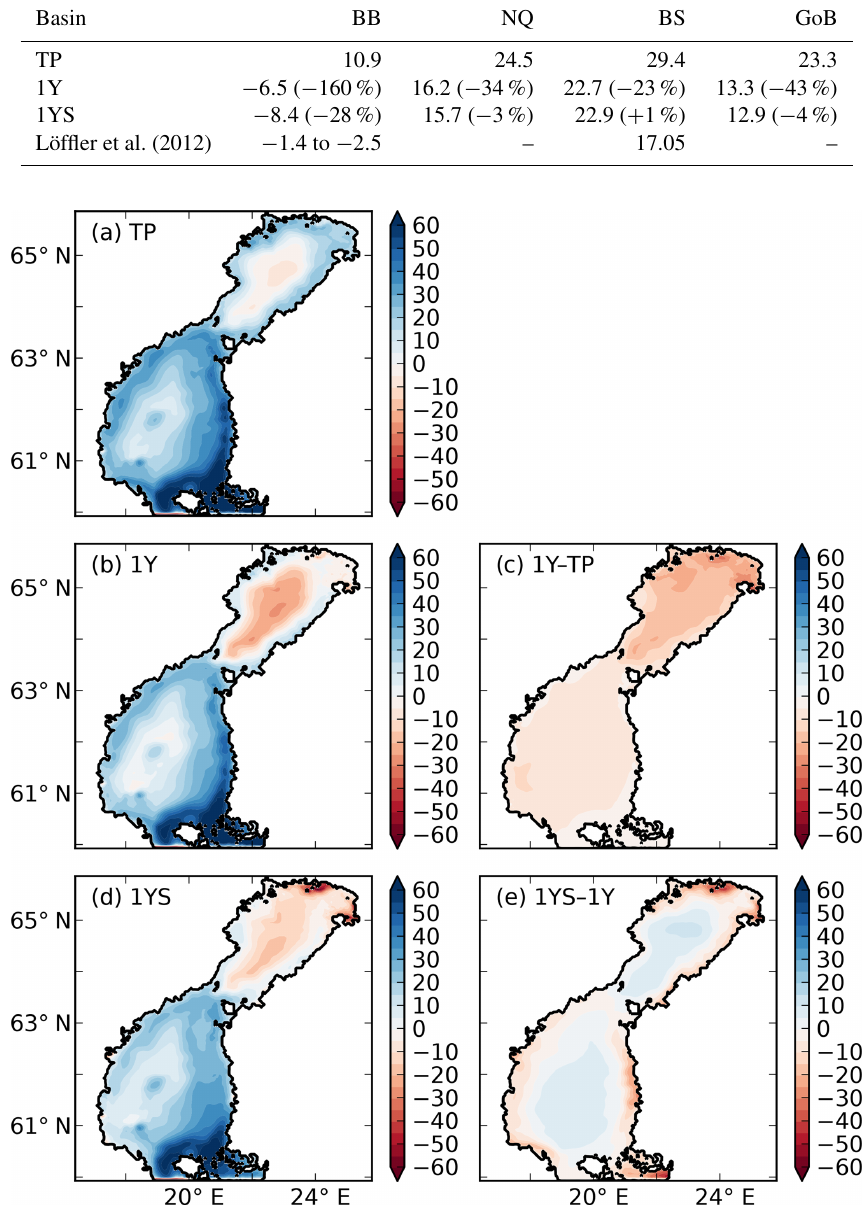
Figure 10. Air–sea CO 2 exchange (gCm − 2 yr − 1 ) in the (a) TP, (b) 1Y and (d) 1YS experiments. Red indicates outgassing of CO 2 to the atmosphere, and blue indicates uptake from the atmosphere. Panels (c) and (d) show the difference in air–sea CO 2 exchange between the 1Y and TP experiments and the 1YS and the 1Y experiments,